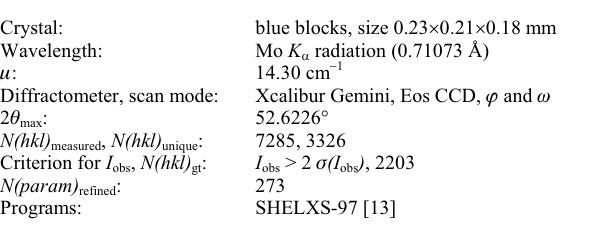
Table 1. Data collection and